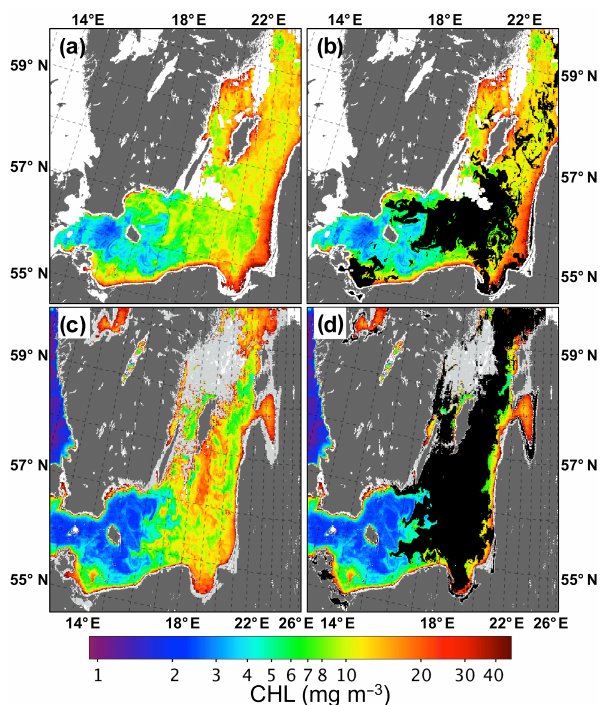
Figure 7. MODIS Level-1A of 11 July 2010 (a, b) and 2005 (c, d) were downloaded from the OBPG website (Ocean Biol- ogy Processing Group, oceancolor.gsfc.nasa.gov) and processed to Level-2 using the standard settings within SeaDAS version 7.3 (seadas.gsfc.nasa.gov). Kahru and Elmgren (2014) recently identi- fied the presence of cyanobacteria accumulating on the sea surface using the SeaDAS Level-2 flag TURBIDW (“turbid water”) when the flag MAXAERITER (“maximum aerosol iterations”) is turned off within the Level-1 to Level-2 processing. Here, Chl a images without (a, c) and with (b, d) the application of the TURBIDW flag are shown; pixels affected by TURBIDW are coloured black. As mentioned by Kahru and Elmgren (2014), the MAXAERITER flag is, by default, turned on within the NASA standard process- ing (e.g. the same used here). A light grey area (c, d) in the north- western Baltic Proper is perceived by the operational processing as too bright (i.e. masked as MAXAERITER) and not processed.